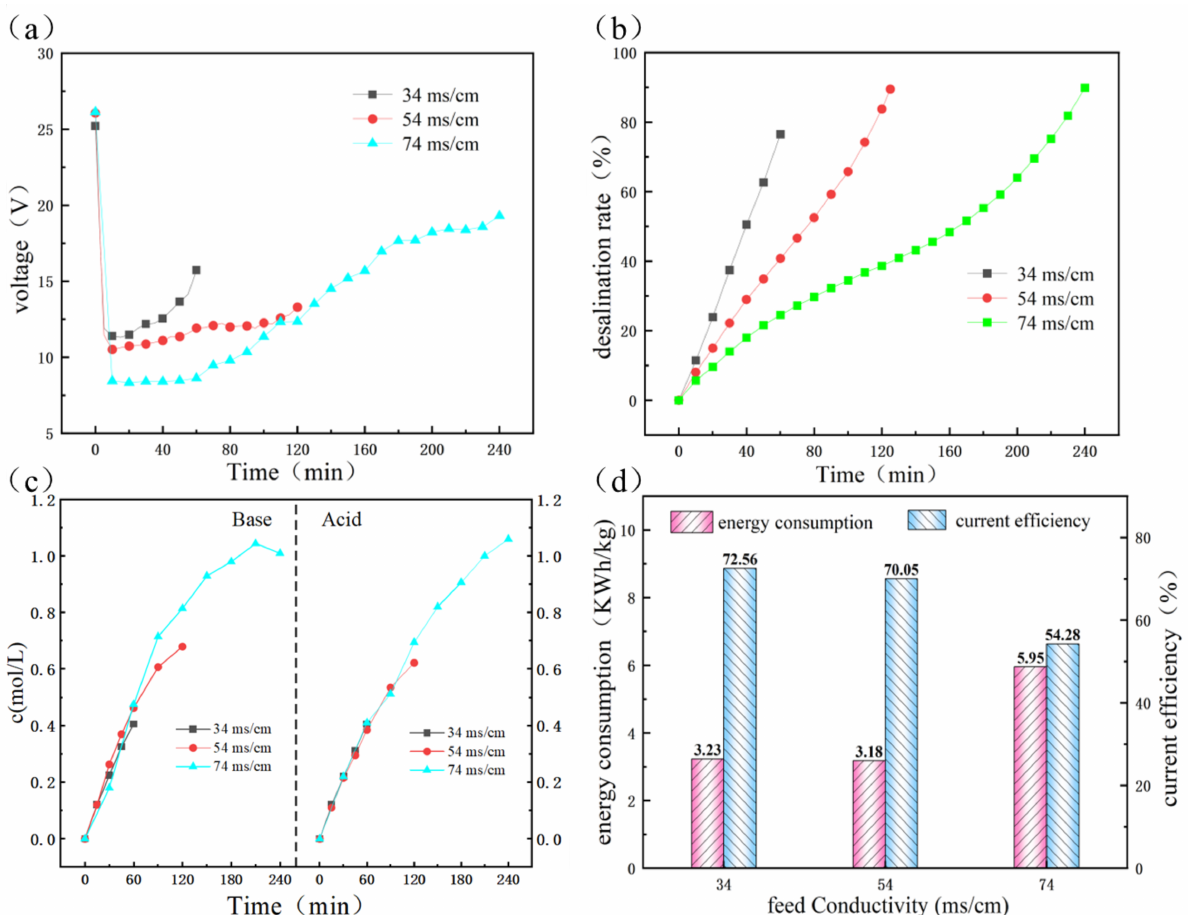
Figure 7. Effect of initial salt concentration on ( a ) membrane stack voltage; ( b ) desalination rate; ( c ) the concentrations of acid and base; ( d ) current efficiency and energy consumption. Current density: 20 mA/cm 2 ; initial HCl and NaOH contents: 0 mol/L. flow velocity: 20